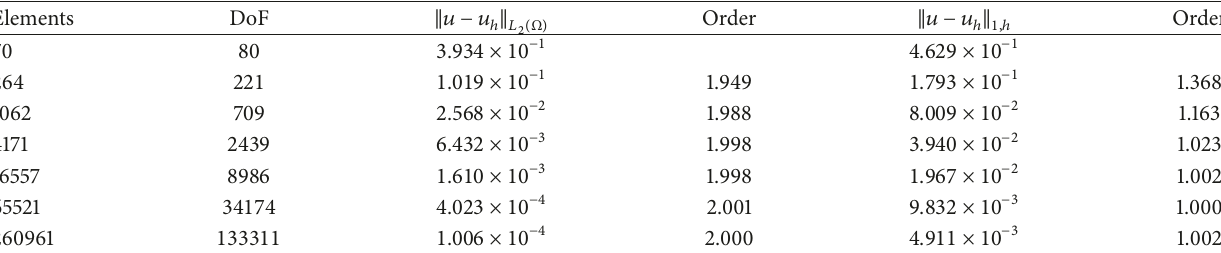
Table 1: 𝐿 2 and 𝐻 1 errors of Example 1.